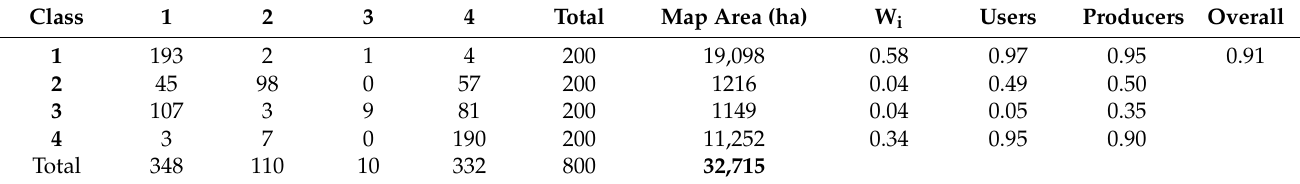
Table 2. Accuracy assessment of the change map error matrix. Class 1 is no change to non-forest areas, class 2 is forest to non-forest transition, class 3 is non-forest to forest transition, and class 4 is no change to forest areas. W i is the proportion of the area that is mapped to a specific class divided by the total mapped area. Map categories are the rows, while reference categories are the columns.